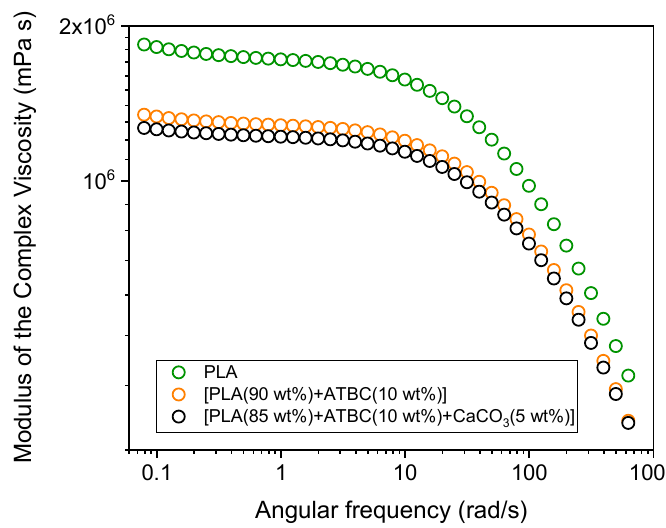
Figure 5. Modulus of the complex viscosity vs. angular frequency at 175 °C for PLA and PLA with the addition of (1) the plasticizer ATBC, and (2) the plasticizer ATBC and the mineral filler CaCO 3 .